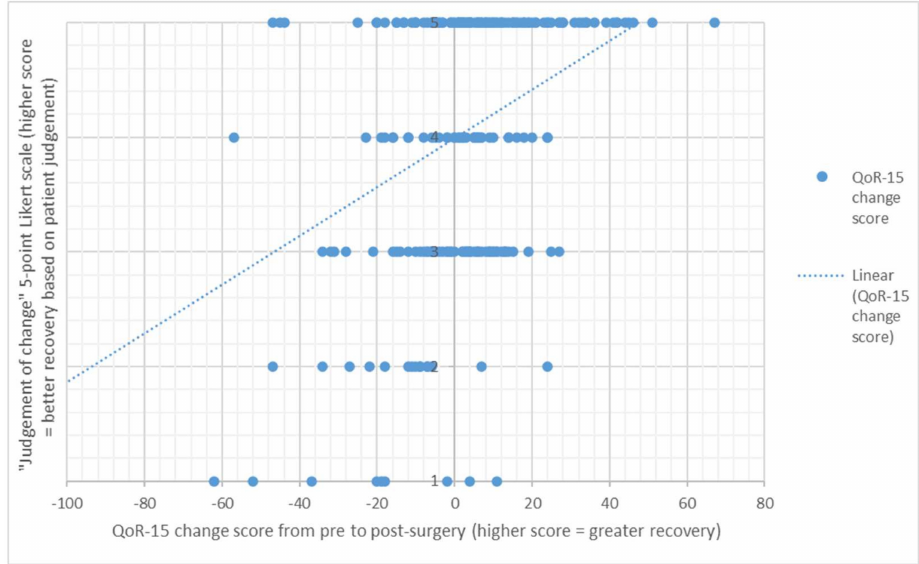
Figure 2. From pre to four weeks post-surgery, scatter plot of the QoR-15 change score and the “judgement of change” score on the 5-point Likert scale, n = 241 (1 = Worse; 2 = A little worse; 3 = Much the same; 4 = A little better; 5 =